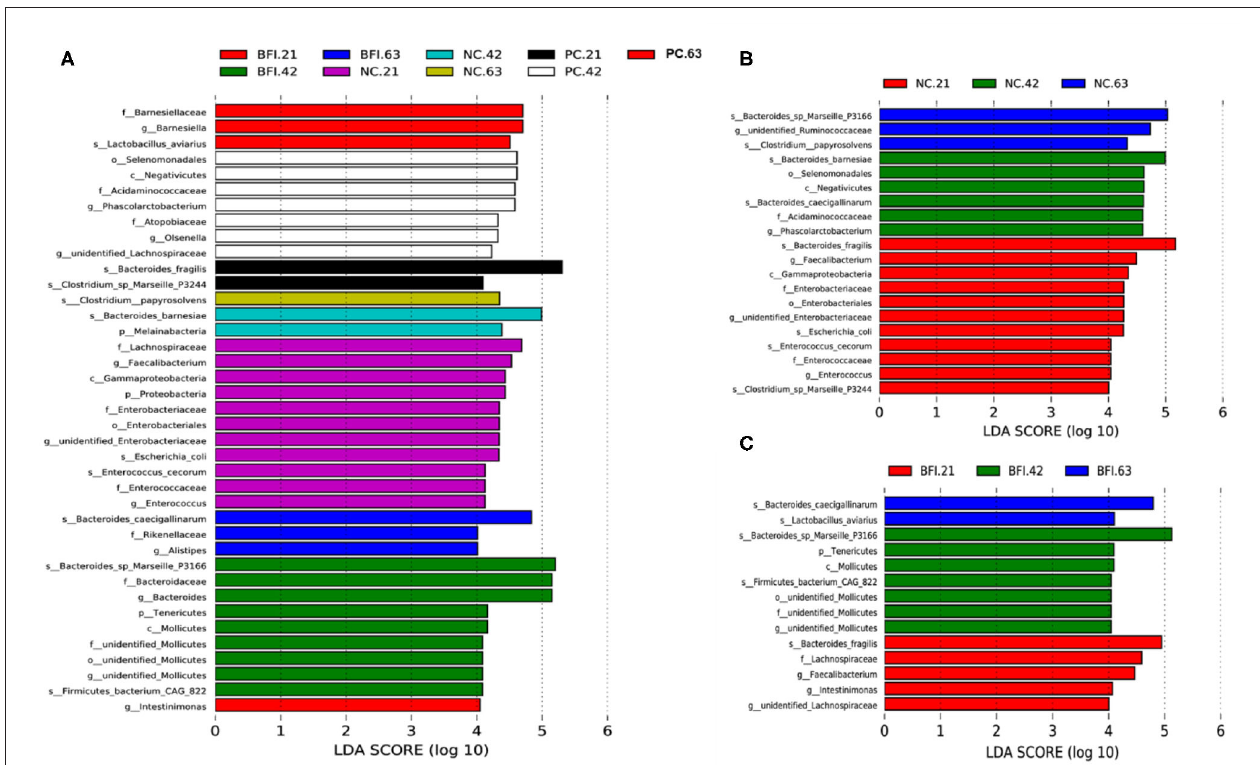
FIGURE 3 | The LEfSe analysis of cecal microbiota in yellow-feathered broilers fed with antibiotic or compound probiotic-supplemented diets. The LEfSe analysis of cecal microbiota among treatment groups at different phases (A) . The LEfSe analysis of cecal microbiota in NC group (B) or BFI group (C) . NC, negative control without in-feed antibiotics. PC, positive control with in-feed antibiotics with 200 mg/kg of oxytetracycline calcium + 250 mg/kg of nasiheptide. BFI, compound probiotics consisting of heat-inactivated Bacillus subtilis and Lactobacillus acidophilus